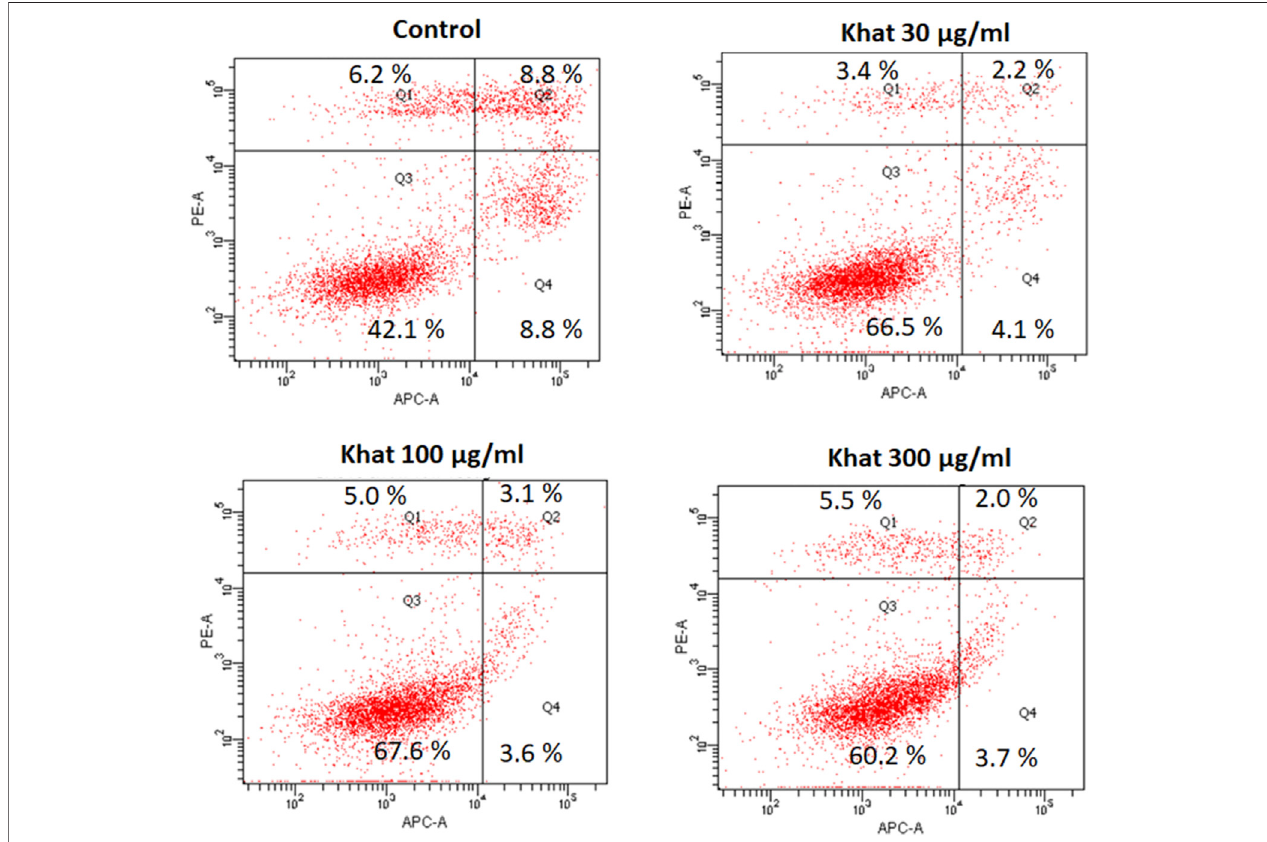
48 h. The control cells demonstrated more positive staining with annexin V-APC which showed a decreasing trend with increasing concentration of the khat extract.